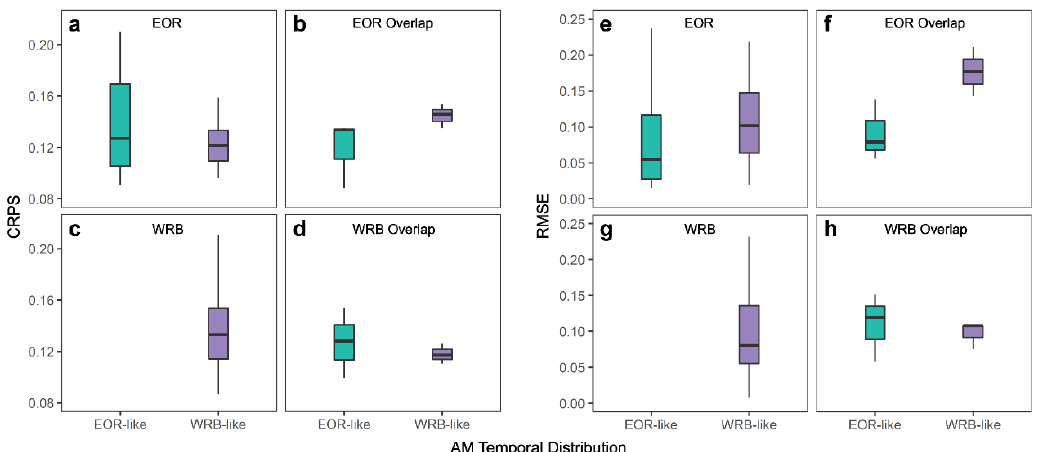
Figure 8. Comparison of station specific CRPS ( a – d ) and RMSE ( e – h ) versus AM temporal distribution by region. EOR ( a , e ) and WRB ( c , g ) display the quantiles of station-specific model performance when stations (excluding overlapping stations) are categorized by EOR-like or WRB-like AM temporal distributions. EOR overlap ( b , f ) and WRB overlap ( d , h ) display the same performance versus categorization for the overlapping stations only, using the EOR and WRB models’ results, respectively.